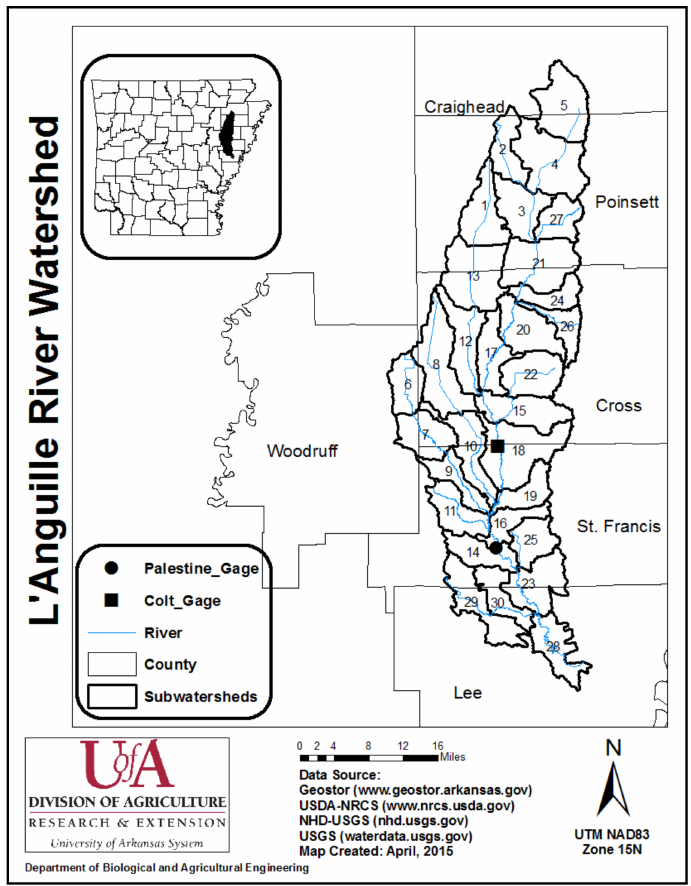
Figure 1. Location of the L’Anguille River Watershed, sub-watershed boundaries, and monitored